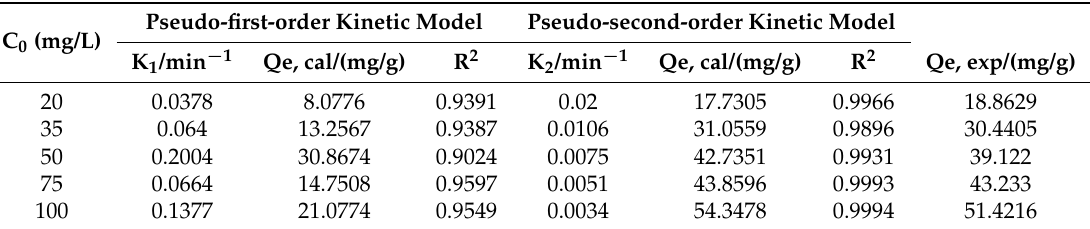
Table 2. Kinetic parameters of different initial concentrations of